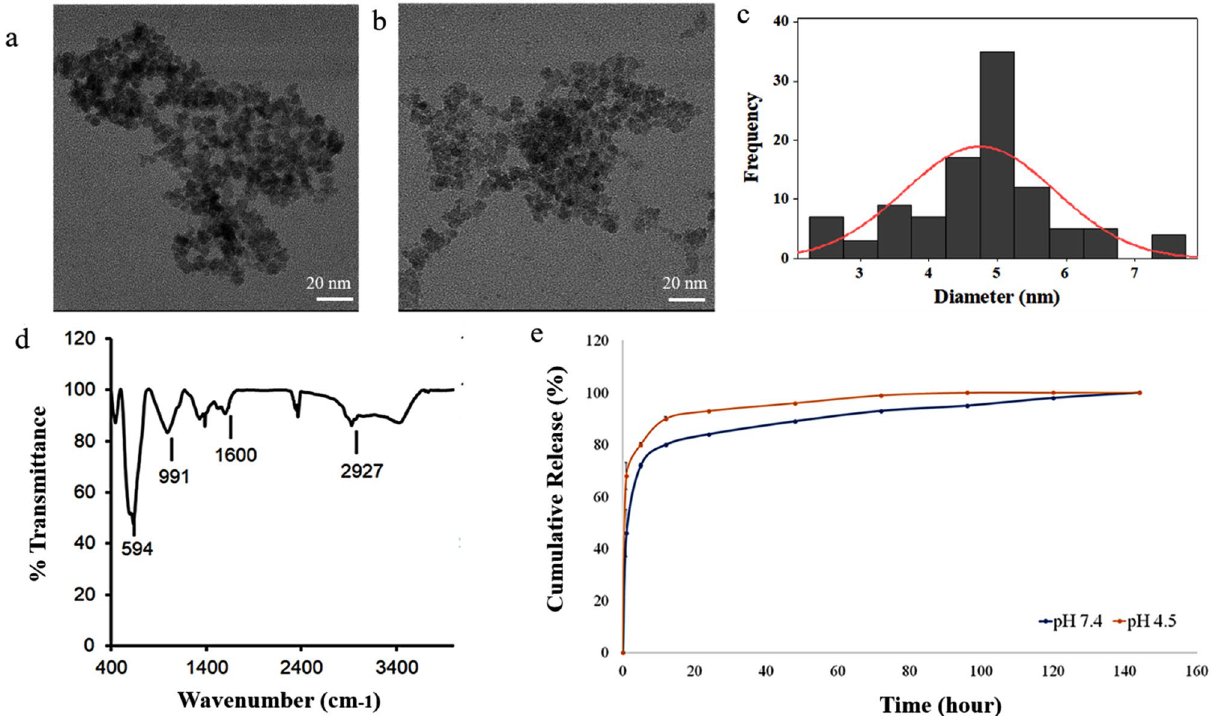
Figure 1. Characterization of nanoparticles: TEM images of ( a ) EDT-IONPs, and ( b ) DOX-EDT-IONPs; ( c ) histogram of EDT-IONP size distribution from the measurement of 100 particles; ( d ) FTIR spectrum of EDT- IONP, ( e ) release of DOX from the DOX-EDT-IONPs in pH 7.4 and